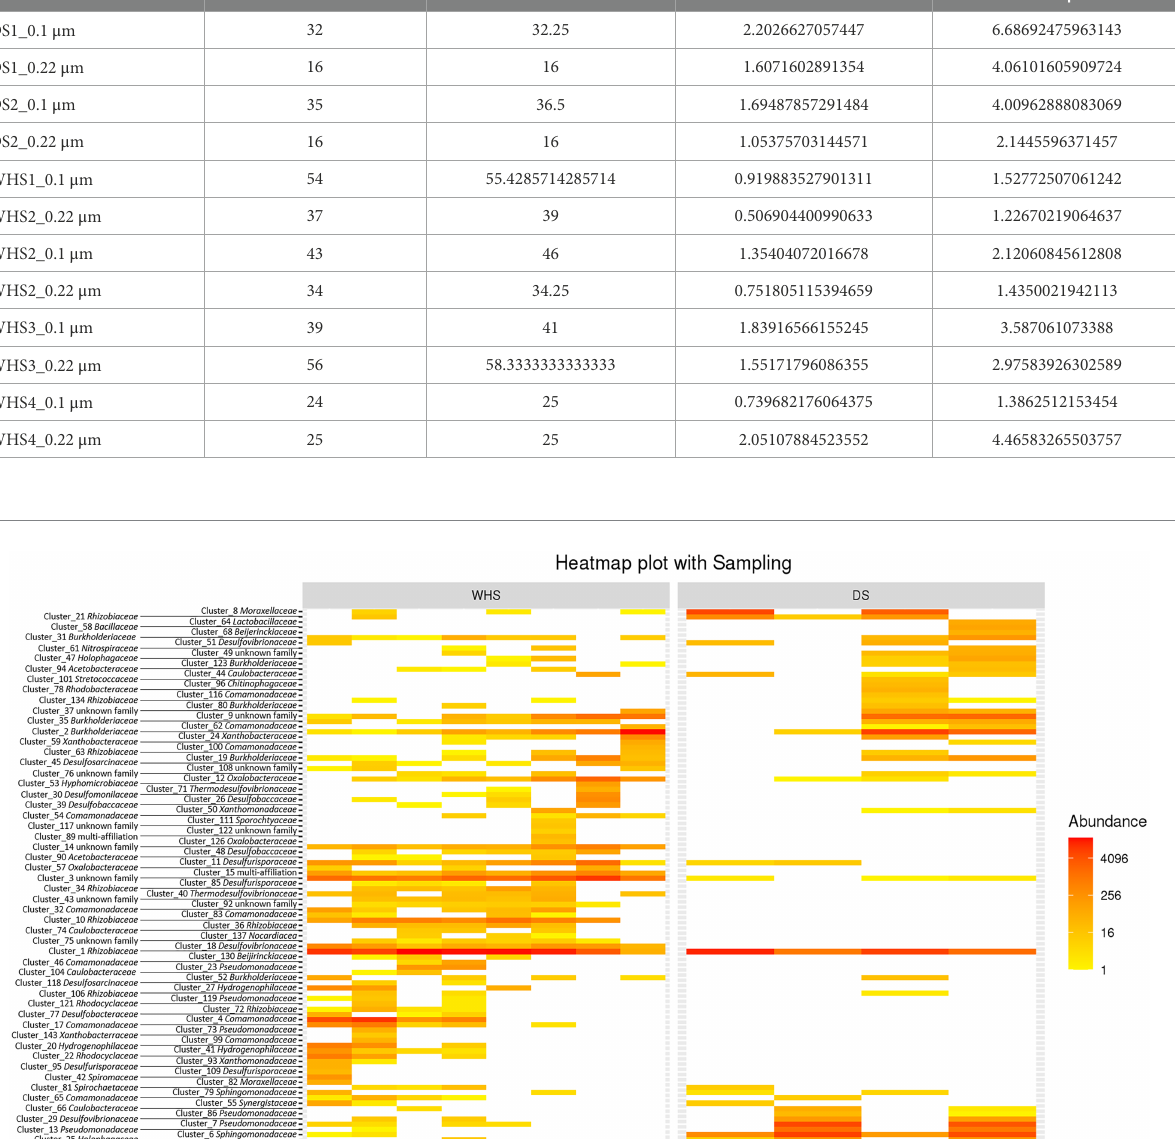
TABLE 1 Alpha-diversity values of microbial community in the formation water collected at the wellhead (WHS) and with the downhole samplers (DS) after a biomass concentration with filters with a porosity of 0.22 μ m and 0.1 μ m from the 0.22 μ m-eluate. Observed Chao